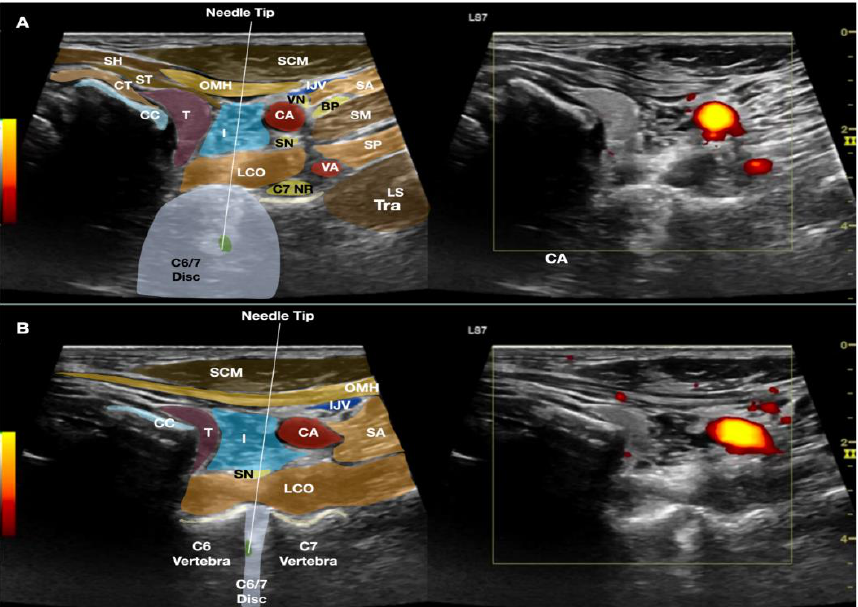
Figure 2. The figure shows the biplanar approach of ultrasound-guided needle placement into the C6/7 intervertebral disc with the trajectory of the needle between the thyroid gland and carotid artery. The image in ( A ) shows the transducer in the transverse plane to the neck and over the level of the C6/7 disc. The image in ( B ) shows that, by pivoting the caudal end of the transducer to the sagittal plane of the neck, the C6 and C7 vertebrae and their intervertebral disc are clearly visible, the needle placement into the nucleus pulposus of the C6/7 disc can be validated. The cricoid cartilage can still be seen in this image due to volume averaging. Abbreviations: BP—brachial plexus (superior trunk);